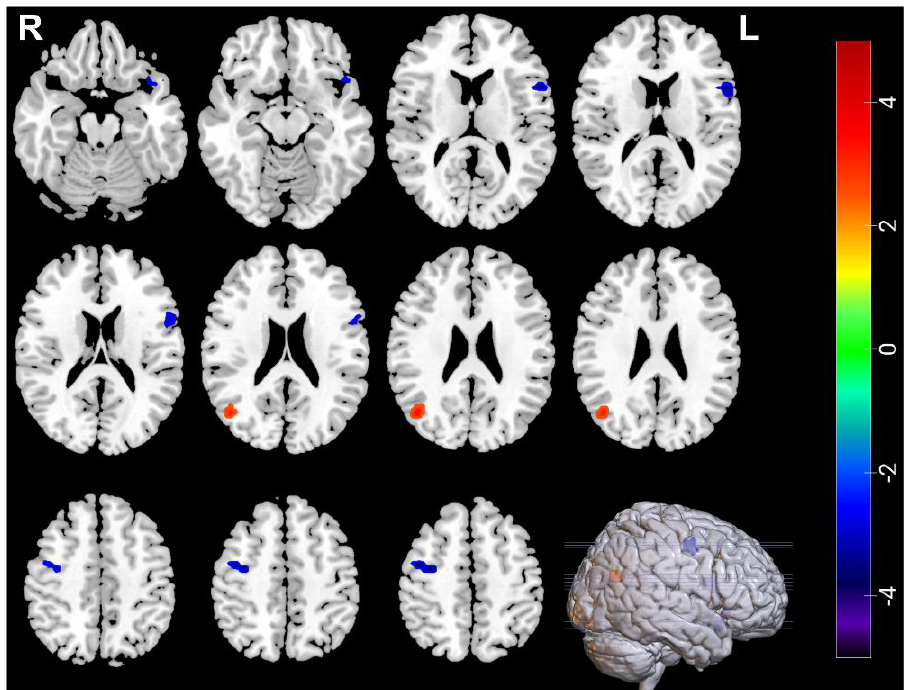
Figure 3. The blue regions represent decreased ALFF in Temporal_Pole_Sup_L, Frontal_Inf_Oper_L and Frontal_Mid_R after ECT, the red regions represent increased ALFF in Occipital_Mid_R in MDDs after ECT. ALFF voxel p < 0.005; GRF correction p < 0.05; cluster size > 24.